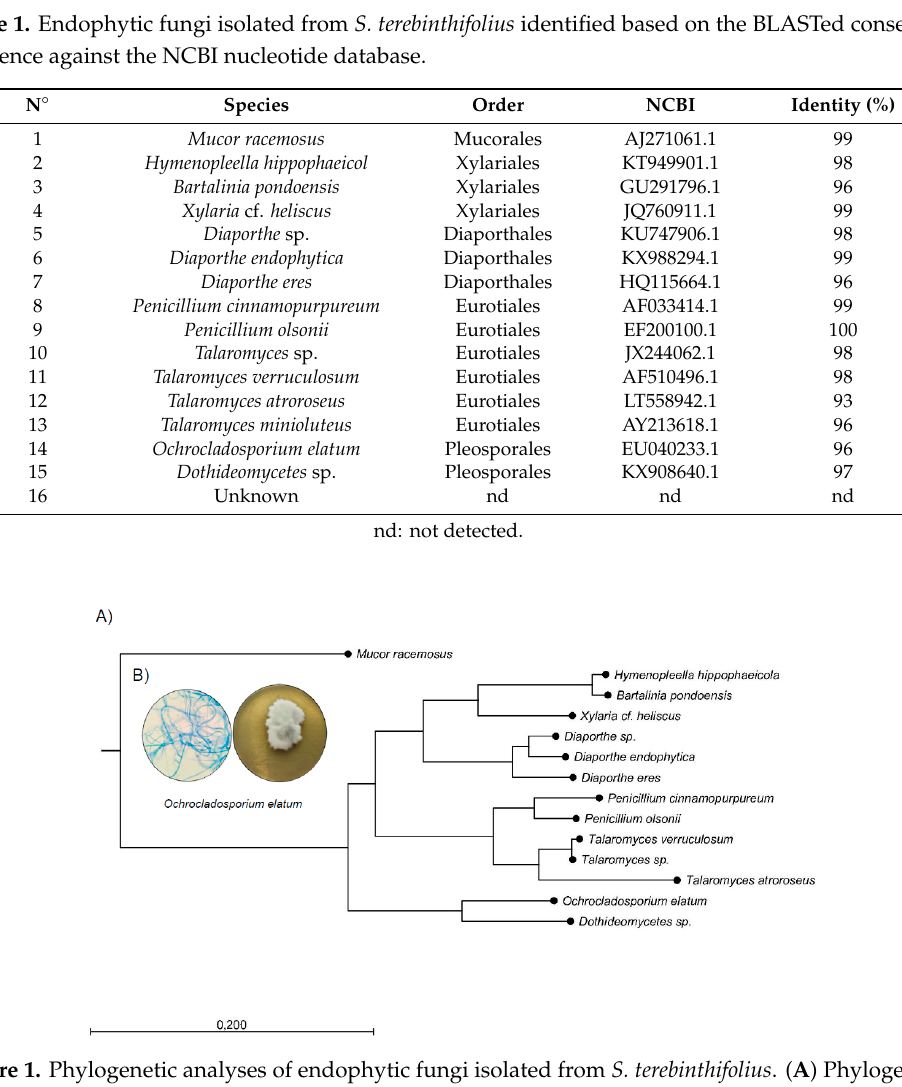
Figure 1. Phylogenetic analyses of endophytic fungi isolated from S. terebinthifolius . ( A ) Phylogenetic tree of maximum probability obtained from the analysis of restriction fragments of the ITS1 region. Numeric values indicate bootstrap support and later probabilities in this order. ( B ) Microscopy (100 × magnification) and macromorphology of the endophytic fungus O. elatum in malt extract